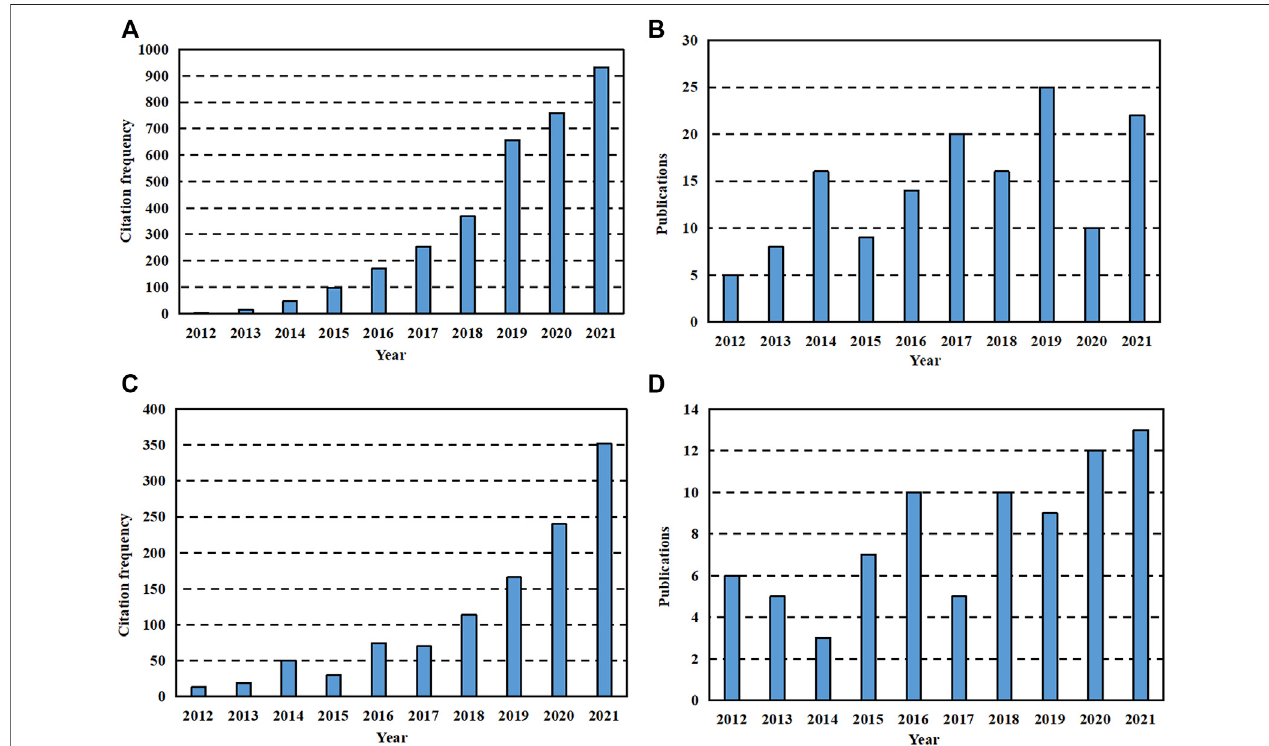
FIGURE 1 | Data search results for last 10 years. (A) The citation frequency of literature with “ GBR ” and “ polymer ” as keywords retrieved on Web of Science in recent 10 years. (B) The publication of literature with “ GBR ” and “ polymer ” as keywords searched on Web of Science in recent 10 years. (C) The sum of citation frequency of literature retrieved on Web of Science with “ GBR ” and “ ceramic ” as one group of keywords as well as “ GBR “ and “ metal ” as another group of keywords in recent 10 years. (D) The sum of the publication of literature retrieved with “ GBR ” and “ ceramic ” as one set of keywords and “ GBR “ and “ metal ” as another set of keywords on Web of Science in recent 10